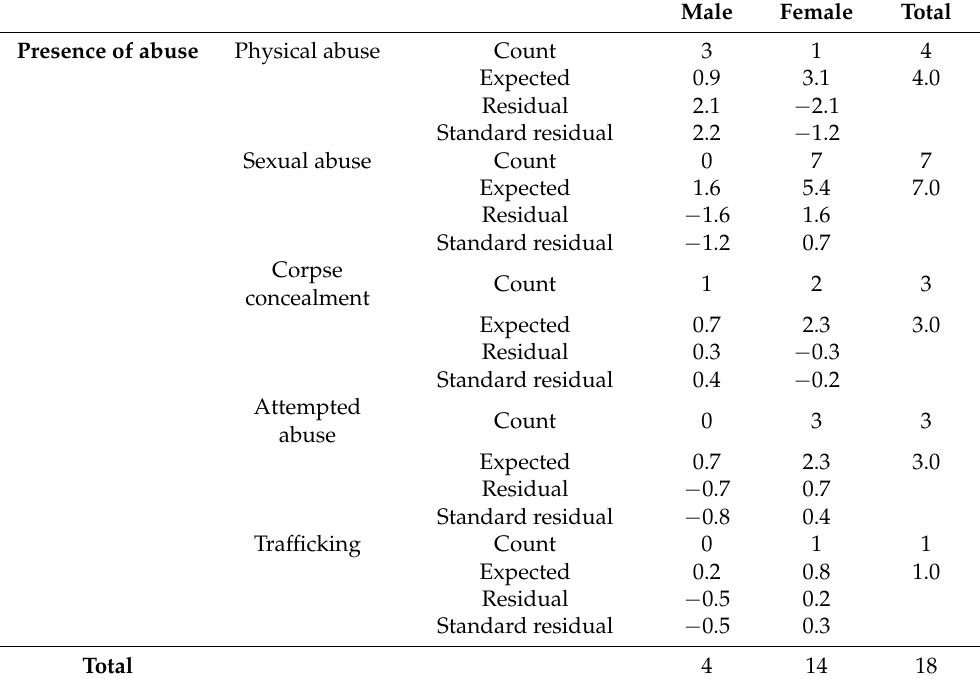
Table 3. Crosstab Abuse*Victim